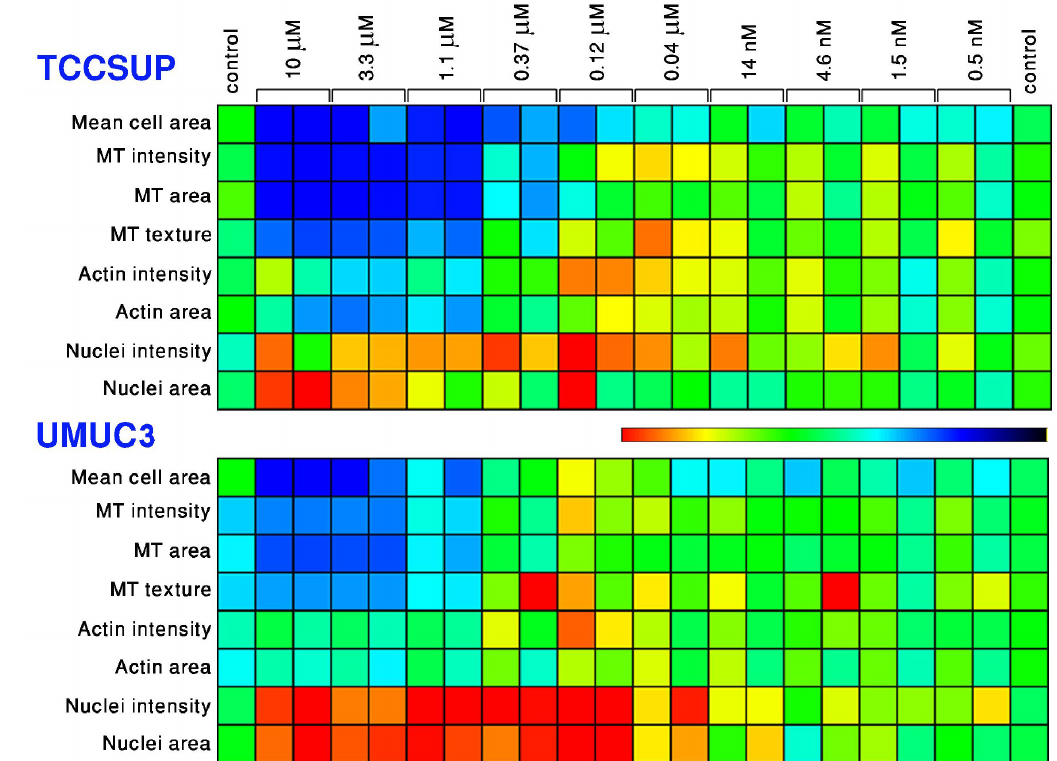
Figure 2. Different parameters report different response profiles. TCCSUP and UMUC3 cell lines were treated by nocodazole. Image analysis recorded nuclei, cells microtubule and actin-related scores. The response curves clearly depend on the attribute used to quantify the effects, and the strength of the effect depends on the cell